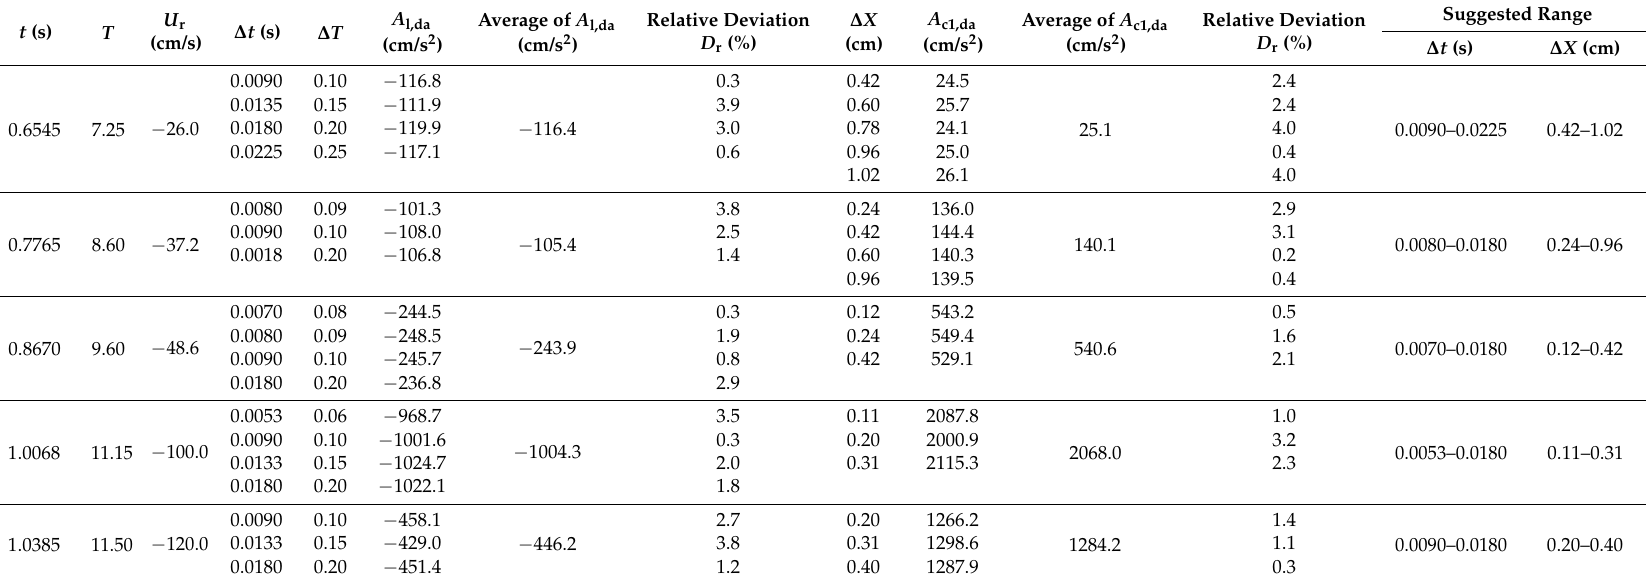
Table 2. A summary of the tested results for obtaining the reasonable values of A l,da and A cl,da with different ∆ t and ∆ X , respectively, together with a list of the promising ranges of ∆ t and ∆ X for t = 0.6545–1.0385 s (i.e., T =